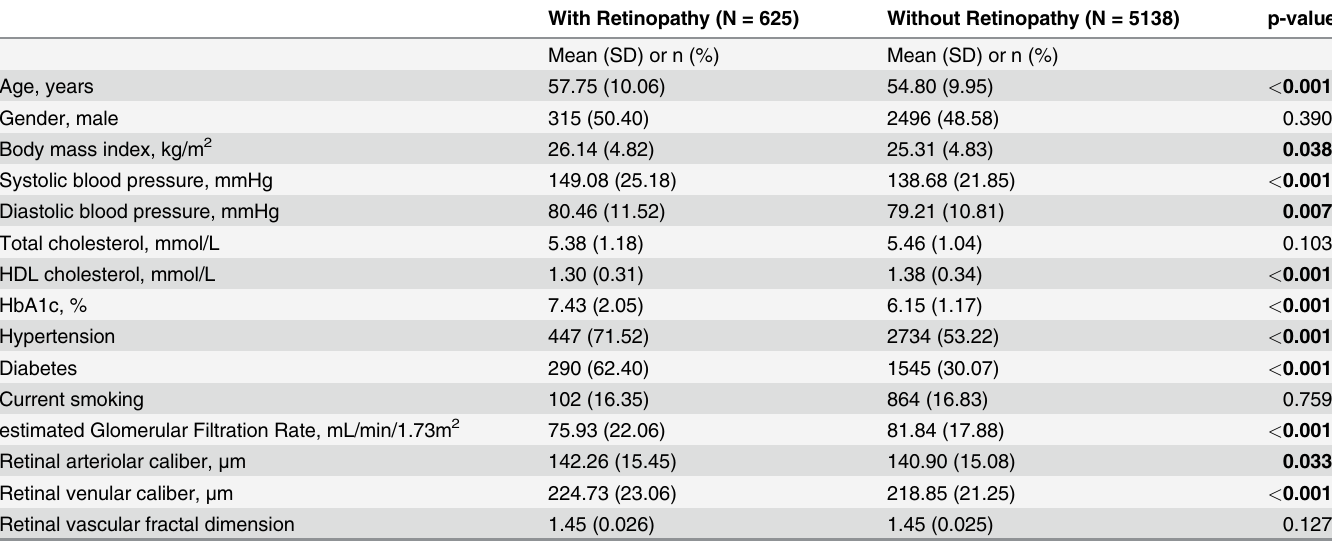
Table 2. Baseline characteristics comparing between those with retinopathy and those